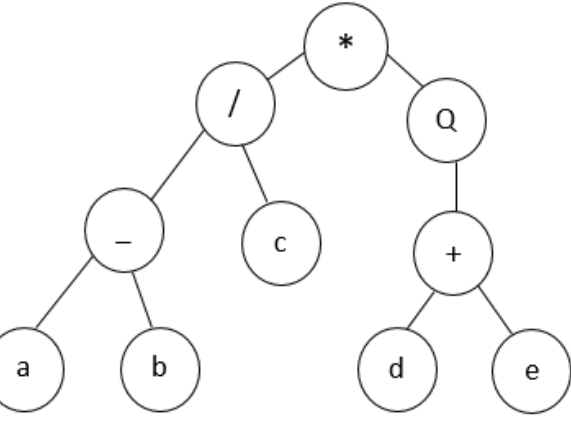
Figure 6. Expression tree of the chromosome (ET).